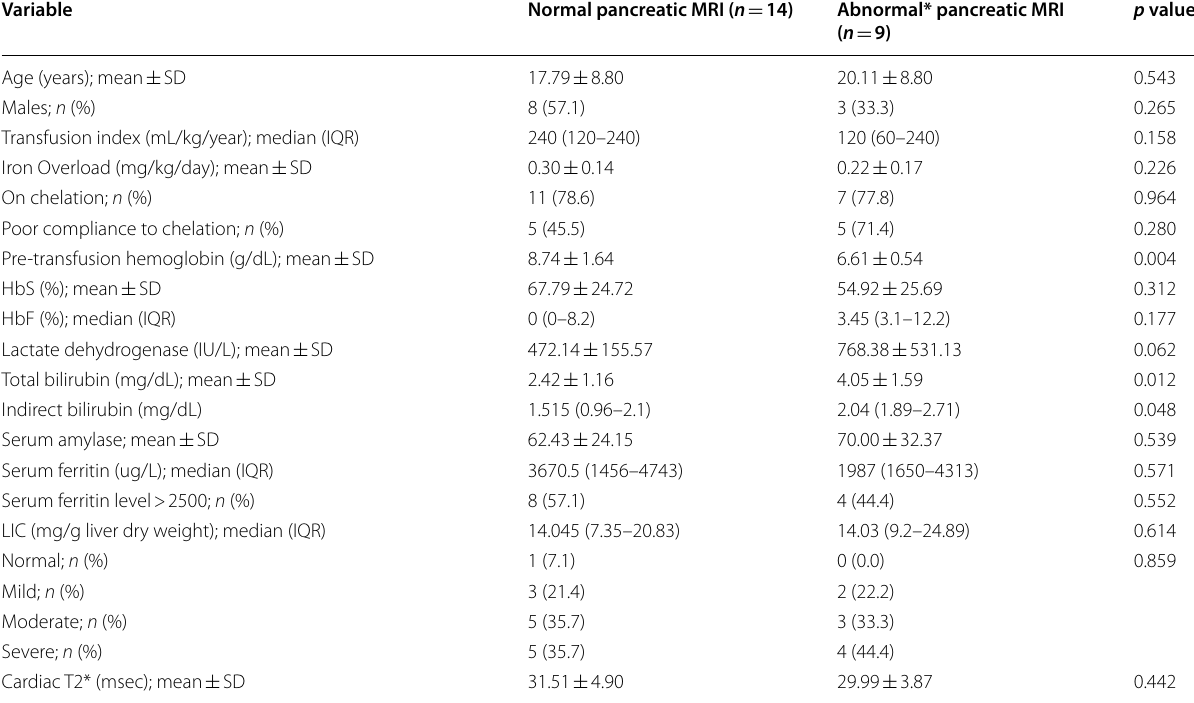
*Patients with Abnormal * pancreatic MRI include those with pancreatic MRI > 100 Hz